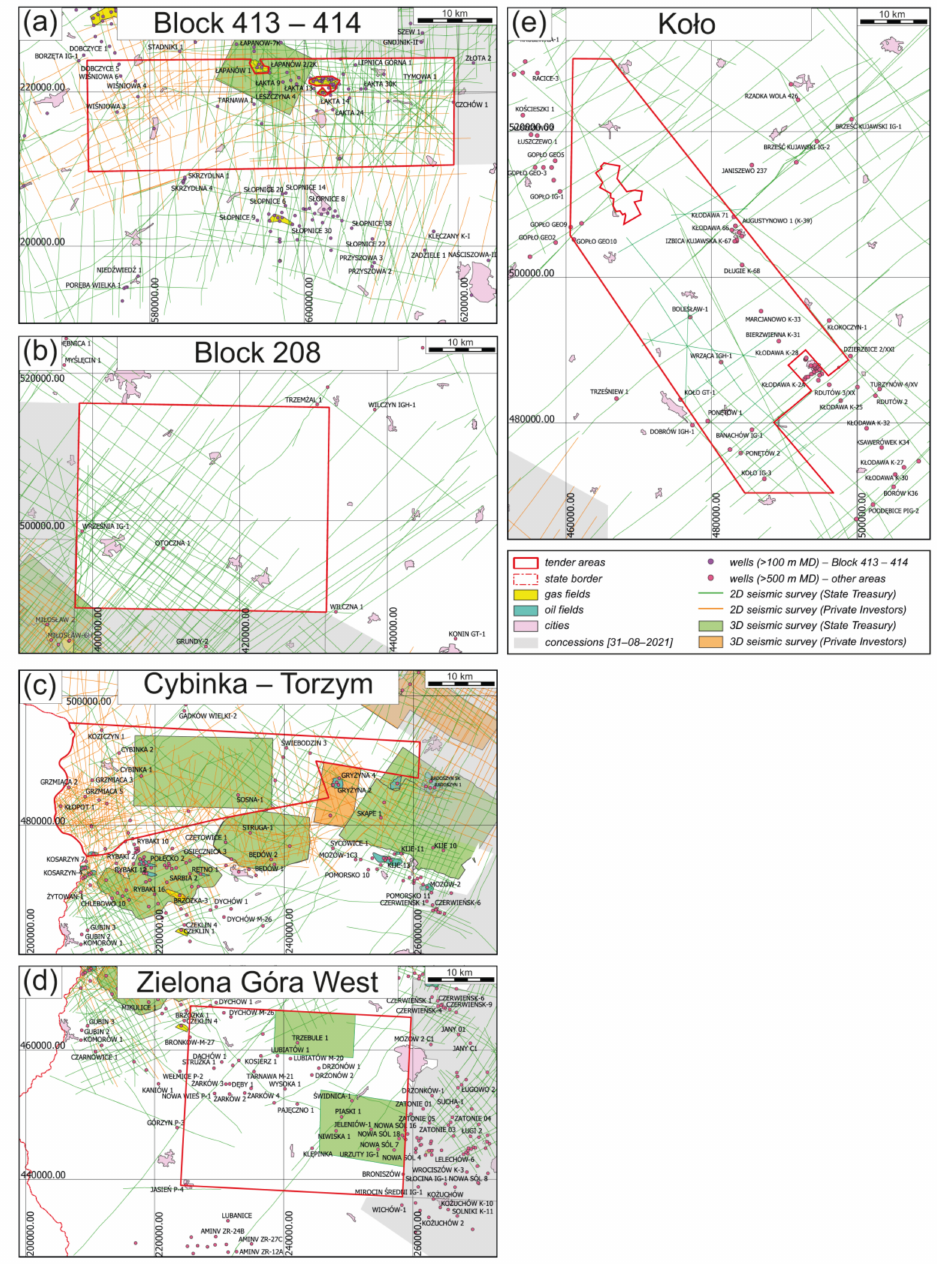
Figure 6. Location of the Block 413–414 ( a ), Block 208 ( b ), Cybinka–Torzym ( c ), Zielona G ó ra West ( d ), and Koło ( e ) tender areas in relation to the other prospecting and exploration concessions, seismic survey, deep wells, and oil and gas fields